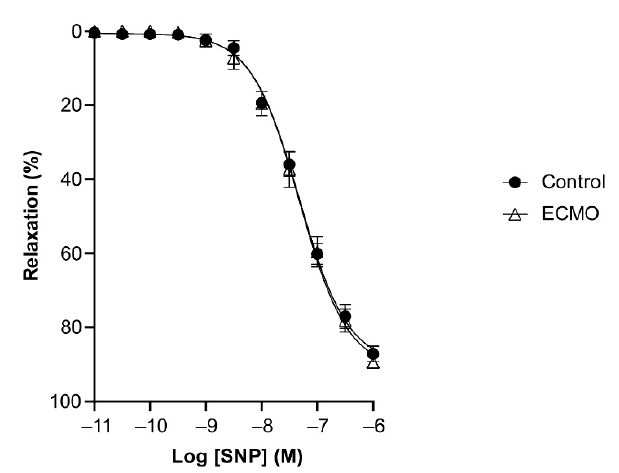
Figure 5. Relaxation of coronary arteries in response to sodium nitroprusside (SNP) was not affected by exposure to ECMO. Cumulative dose–response curves to SNP in porcine coronary artery rings in control and ECMO group. Vessels were precontracted with U46619 (1 μ M). Data points are presented as mean ± S.E.M ( n = 5 in both groups). ECMO: extracorporeal membrane oxygenation.